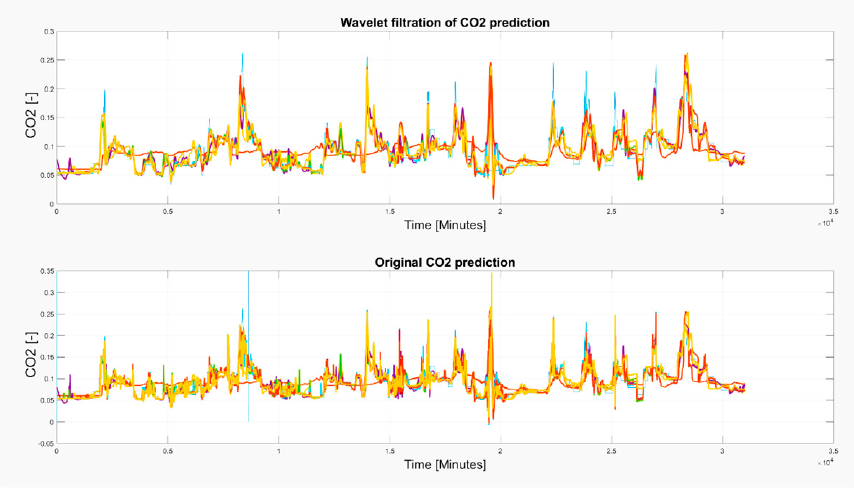
Figure 20. An example of whole-month prediction from November 2018 of the CO 2 signal. Filtration is done by using the Db6 wavelet with 6-level decomposition.